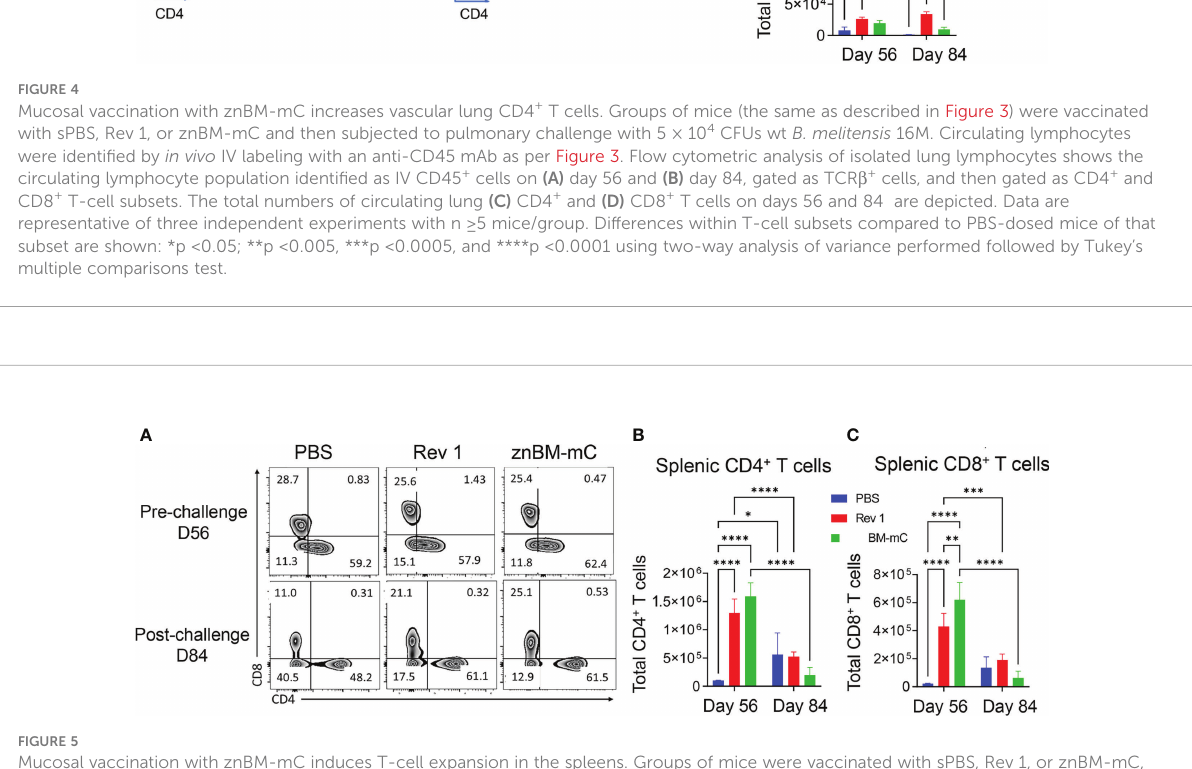
production with vascular IFN- g being produced by mostly T cells and, and over three-quarters vascular TNF- a and IL-17 produced by T cells. IFN- g , TNF- a , and IL17 are mostly derived from noncirculating T cells (Supplementary Figure 1B). Further analysis of total lung T cells at pre- (day 56) and post-challenge (day 84) revealed that the noncirculating T cells for both Rev 1- and znBM-mC-vaccinated mice contained the majority of